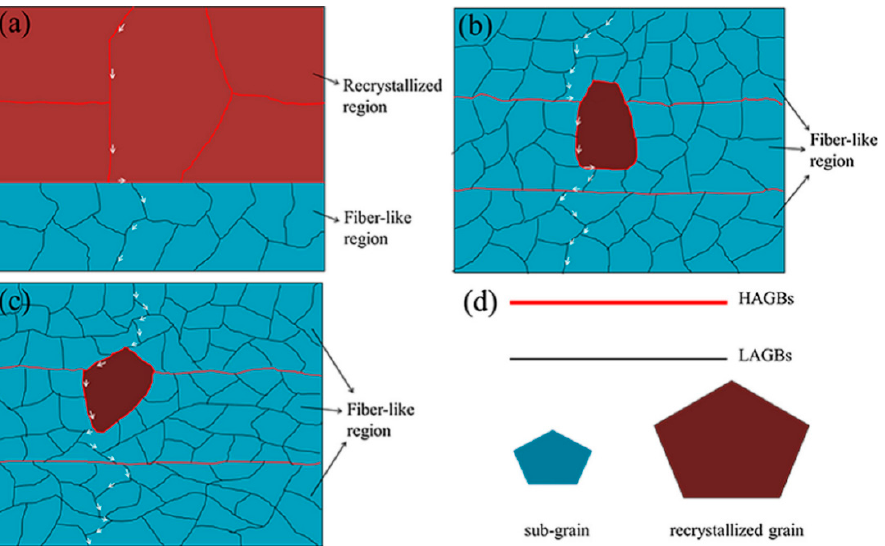
Figure 4. Schematization of SCC crack propagation paths for three peak-aged alloys: ( a ) A0; ( b ) A1; ( c ) A2; ( d ) the type of GB and grain .Adapted with permission from ref. [41]. 2018 Li et al. ( c ) A2; ( d ) the type of GB and grain. Adapted with permission from ref. [41]. 2018 Li et